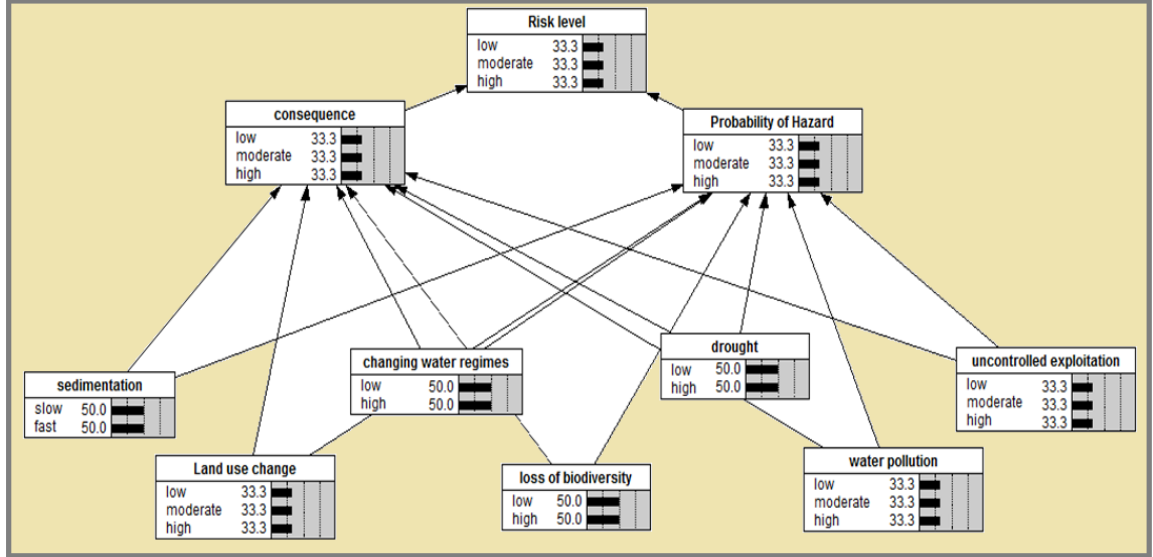
Figure 4. An initial BBN model developed to determine the levels of environmental risks at SIWs.